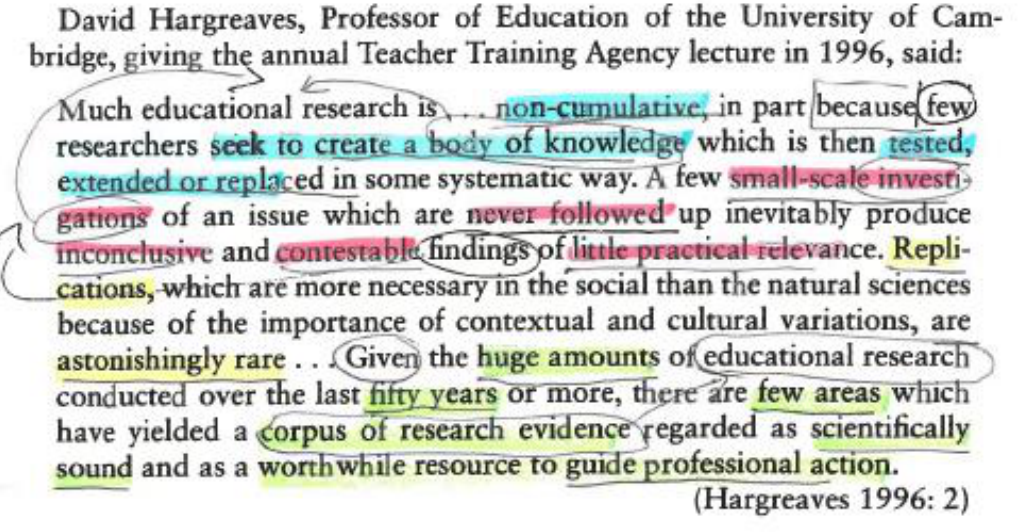
Figure 4 : Extract from Bassey (1999) for detailed reading, showing annotations made in